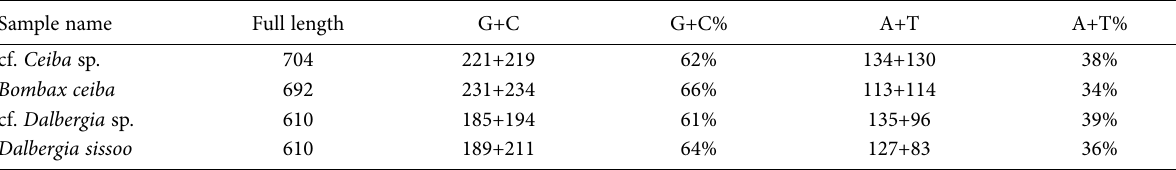
Table 7. Sequence length and GC and AT content. Sample name